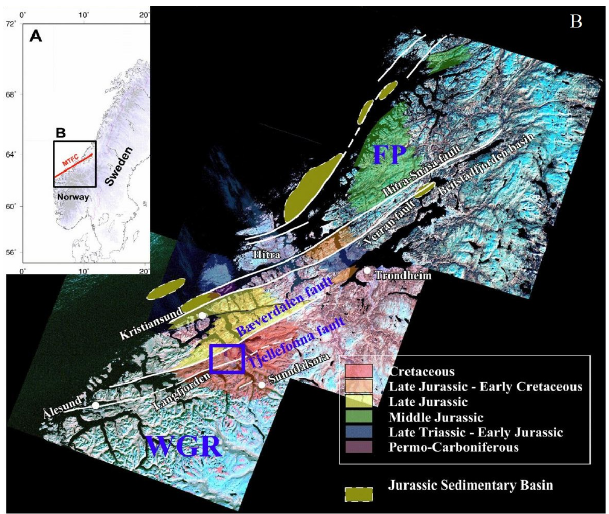
Fig. 1. Principal structural features of the Møre-Trøndelag Fault Complex (MTFC) and surrounding regions. (A) Location of the Mre-Trndelag Fault Complex (MTFC) onshore Norway. (B) Com- position of three LandSat scenes showing the major lineaments of the MTFC (after Redfield et al., 2005). The blue frame depicts the study area. FP- Fosen Peninsula, WGR- Western Gneiss Region.